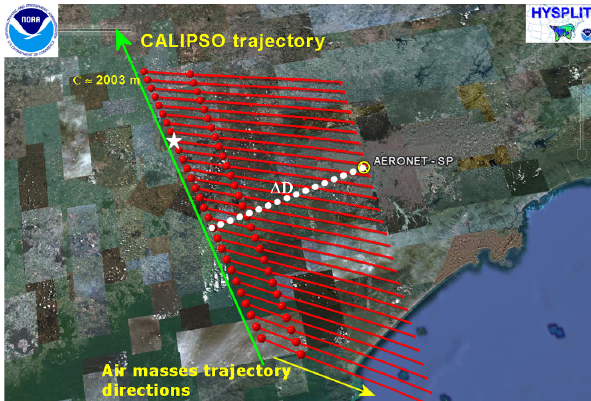
Fig. 4. HYSPLIT backward trajectories in the region of the São Paulo AERONET site for 26 May of 2007. The forward trajectories start around the time of CALIPSO’s closest approach (17:08UTC). 1D is the closest distance between CALIPSO trajectory and the AERONET site, in this case 71.7km. The initial lat/lon coordinates have been used as the central values of lat/lon for each 5km hor- izontal resolution aerosol-layer profiles. The initial altitude for the trajectories, i.e., the backscatter centroids, was in this case about 2003m.